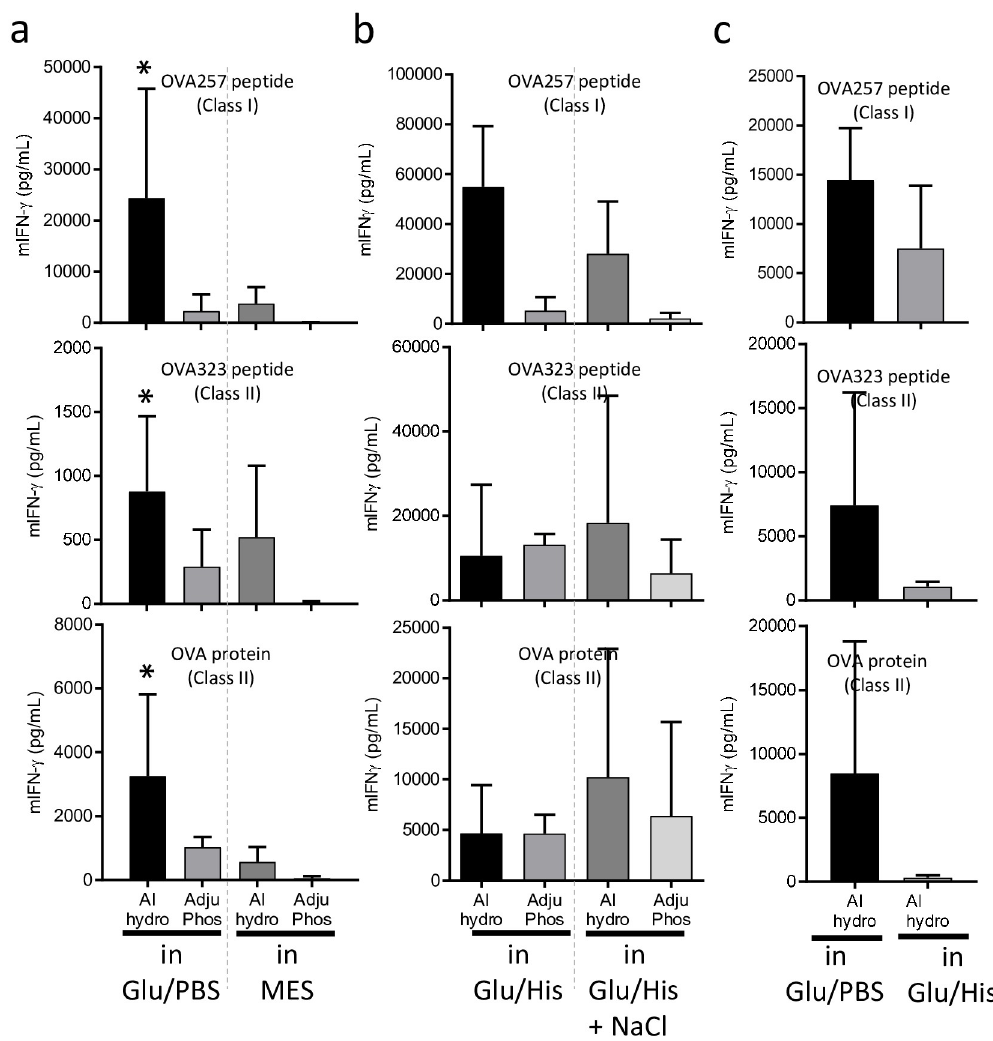
Fig 5. Induction of T cell response by different aluminum salt and buffers. C57BL/6J mice were immunized i.d. with OVA plus the indicated combination adjuvants and buffers at the tail base. OVA (10 μ g), DOTAP (100 μ g), D35 (10 μ g), and Alhydrogel (40 μ g) in the indicated buffers were used. Seven days after immunization, splenocytes were stimulated in vitro with OVA257-264 peptide that induced MHC class I restricted response (CD8 + T cell response), and OVA323-339 peptide, or OVA protein that induced MHC class II restricted response (CD4 + T cell response). After 24 h, the concentration of mouse IFN- γ in the culture supernatant was measured by ELISA. (a) Comparison of Glu/PBS and MES buffers (b) Comparison of Glu/His and Glu/His + NaCl solutions. (c) Comparison of Glu/PBS and Glu/His buffers. The bar graph indicates the mean + SD of cytokine concentrations derived from three mice per group. Statistical significances compared with Alhydrogel in Glu/PBS and AdjuPhos in MES (in panel (a)) were detected and are shown by asterisks in the bar graph; � p < 0.05. Other comparisons did not reach statistical significance (non-parametric test).